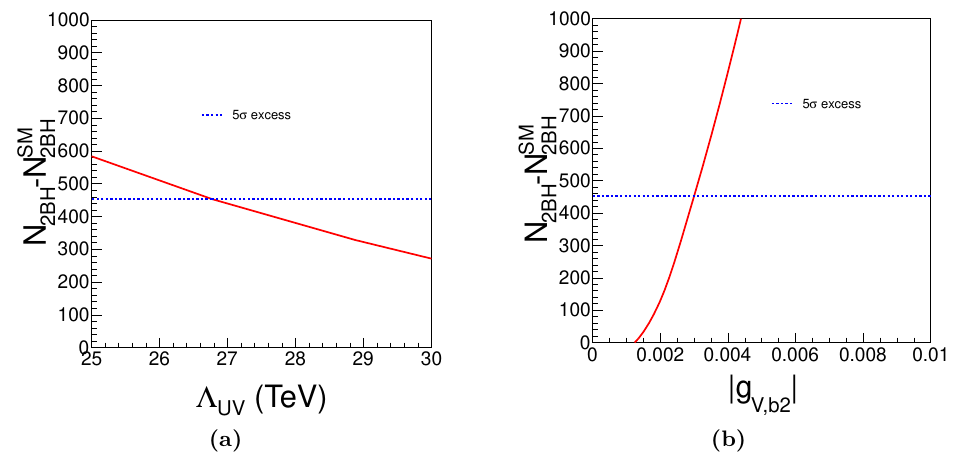
Figure 7 . The 5 σ excess constraint obtained from 2BH events on new physics cutoff at 100 TeV hadron collider is demonstrated in (a), while (b) is the corresponding g